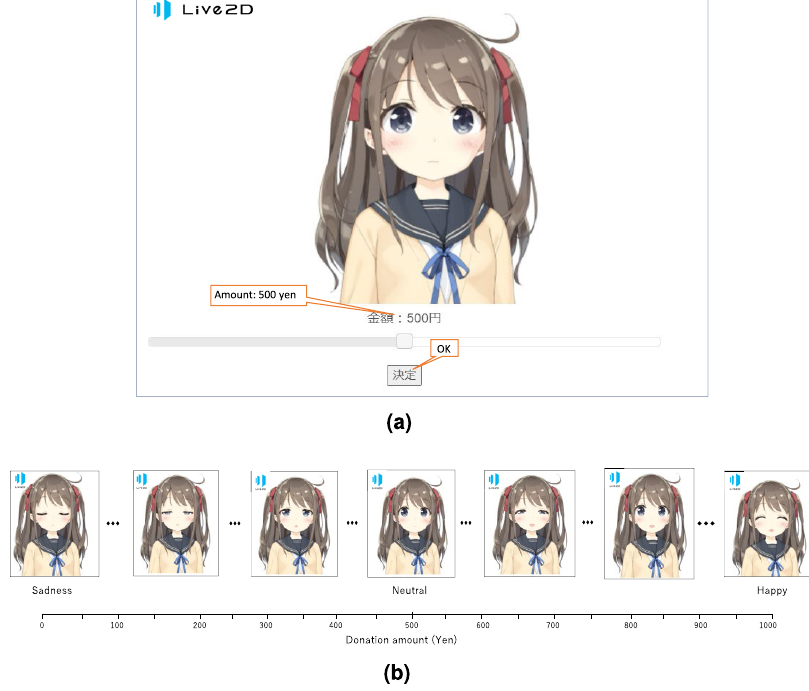
Figure 1. User interface and changes in the facial expression of the avatar. The anime character imagery figures were obtained from Live2D Cubism, Live2D Inc.; all rights reserved. ( a ) User interface. The facial expressions of the avatar and the amount of the donation change according to the position of the slider bar. If the slider bar goes to the left end, the amount is 0, and the avatar expresses sadness. If the slider bar goes to the right end, the amount is the maximum value, and the avatar is happy. In the middle, the amount is the mean, and the avatar is neutral. ( b ) Changes in the facial